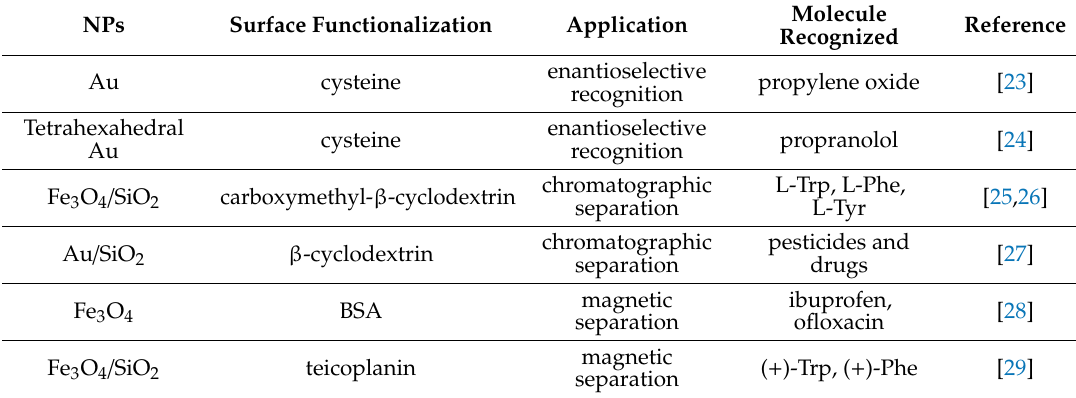
Main applications of chiral NPs through enantioselective recognition and their principal